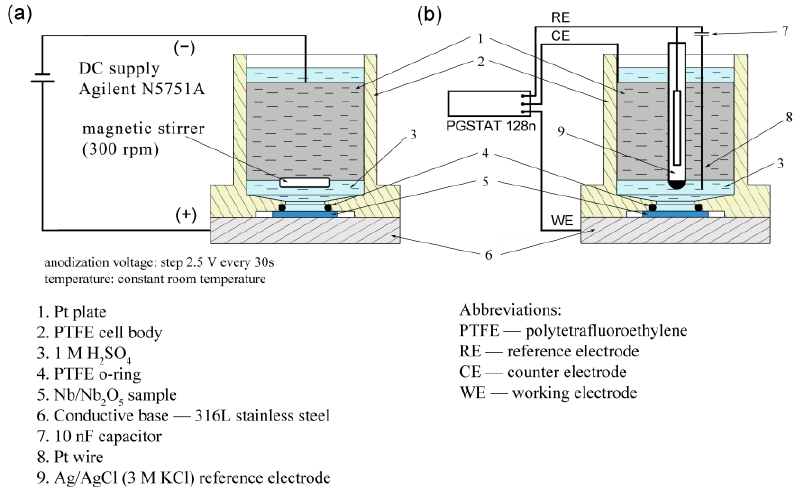
Figure 1. Electrochemical cell setup scheme: ( a ) anodizing samples, ( b ) EIS measurements. Ellipsometric measurement were performed using a SENTECH SE400adv ellipsometer (Berlin, Germany), choosing an angle of incidence of 70°. The example ellipsometric parameters nu , ku , ns and ks are presented in Figure 2 and were taken from the work of Arsova kloi0p9, et al. [12].